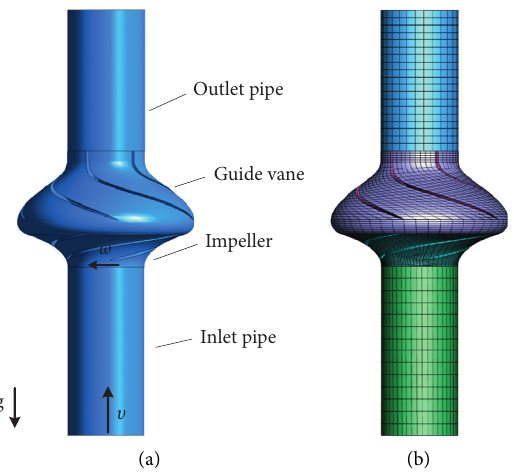
Figure 4: Model pump: (a) 3D model; (b) grid